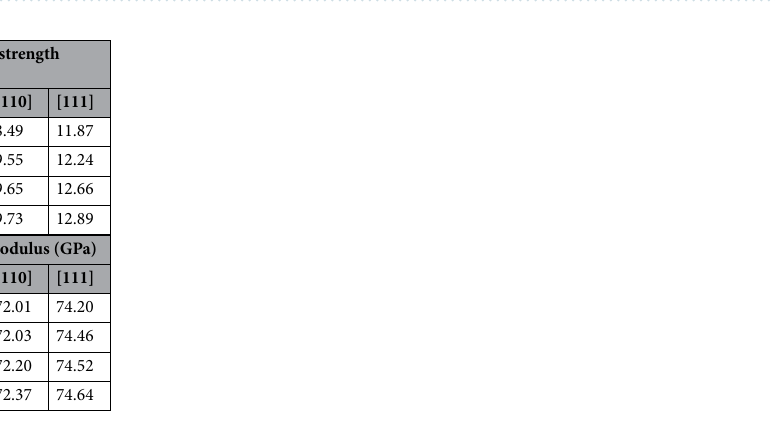
Table 2. Calculated room temperature fracture stress and elastic modulus of three different crystal-oriented zinc-blende ZnSe NWs at different strain rates.